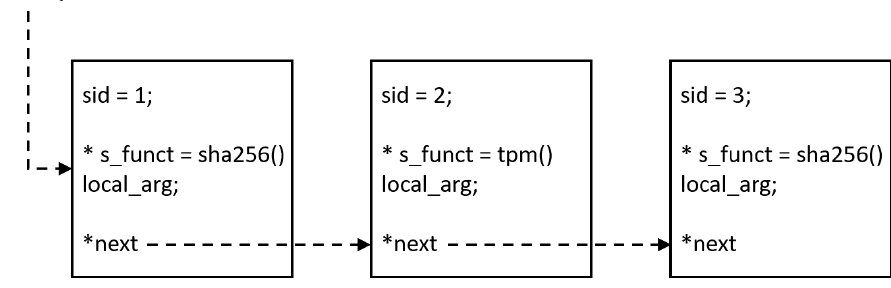
Figure 7. Secure service queue with